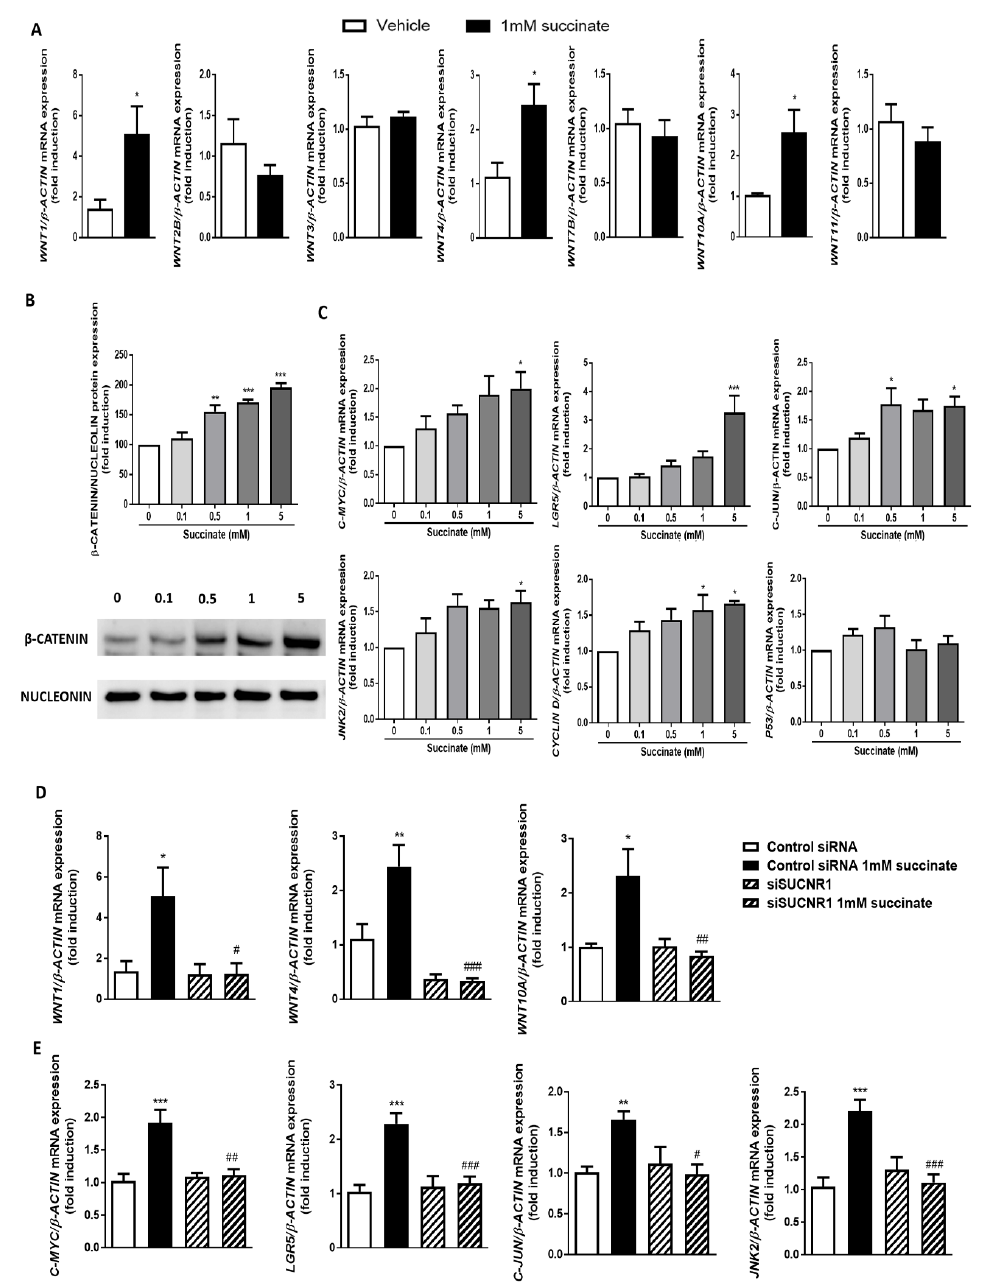
Figure 5. Succinate activates Wnt signaling pathway through SUCNR1 in intestinal epithelial cells. HT29 cells were treated with different concentrations of succinate (0, 0.1, 0.5, 1 and 5 mM) for 48 h. ( A ) Graphs show the expression of several Wnt ligands in HT29 treated cells. Succinate induces the expression of WNT1, WNT4 and WNT10A ( n = 5). Bars in graphs represent mean SEM and significant differences vs. non-treated HT29 cells are shown by * p < 0.05. ( B ) Nuclear proteins were isolated, and the expression of nuclear β -catenin was analyzed by Western blot. Graph shows the protein levels of nuclear β -catenin in HT29-treated cells, and the image corresponds to a Western blot representative of a total of 5 independent experiments. ( C ) Graphs show the expression of the Wnt target genes C-MYC, LGR5, C-JUN, JNK2, and CYCLIN D and of the tumor suppressor P53 ( n = 5). Bars in graphs represent mean ± SEM, and significant differences vs. non-treated HT29 cells are shown by * p < 0.05 or *** p <